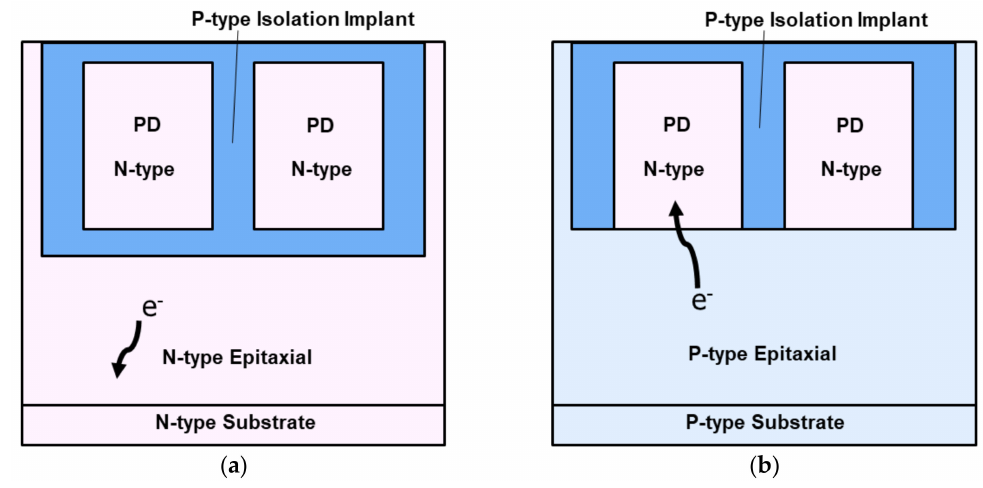
Figure 3. Simple photodiode (PD) schematic with ( a ) N-type substrate, ( b ) P-type substrate.